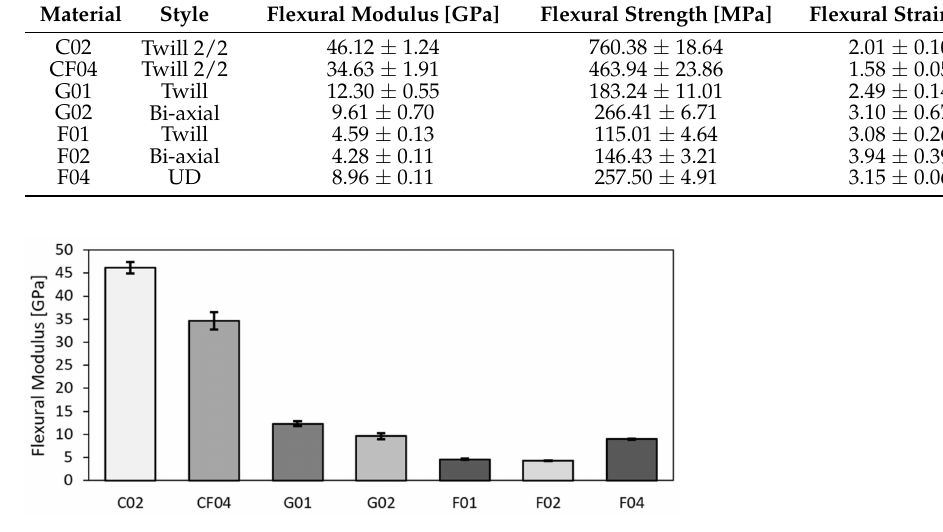
Figure 6. Flexural moduli of test samples.